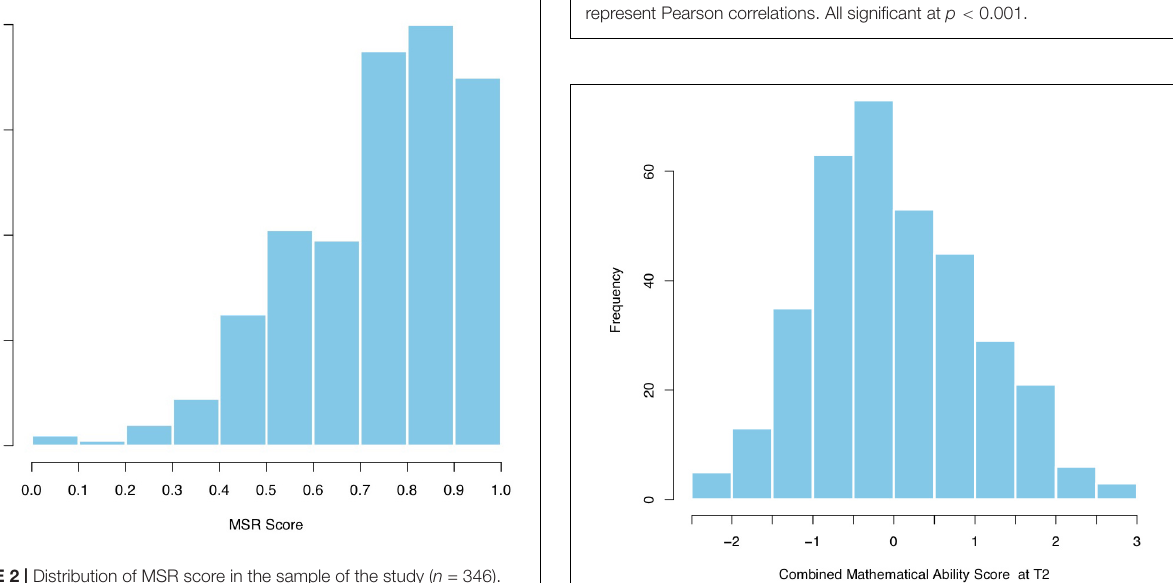
“potential specific learning disorder in math” with the MSR were later classified as “not at risk” (compared to 7% with the